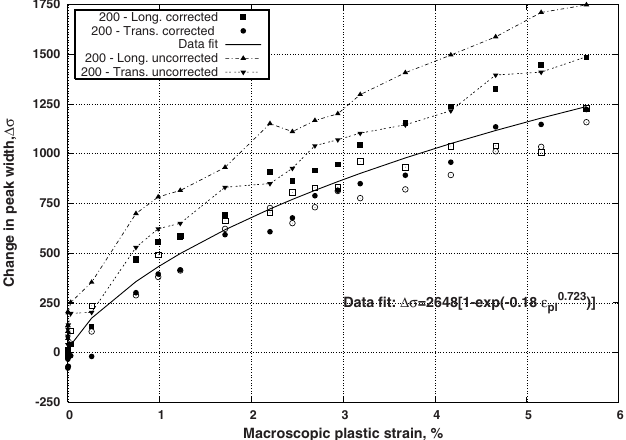
(cid:70)(cid:105)(cid:103)(cid:46) (cid:50)(cid:46) Variation in [200] peak σ component as a function of macroscopic plastic strain, as recorded during the in-situ tensile test. Open and closed symbols represent the loaded and unloaded states for each plastic strain